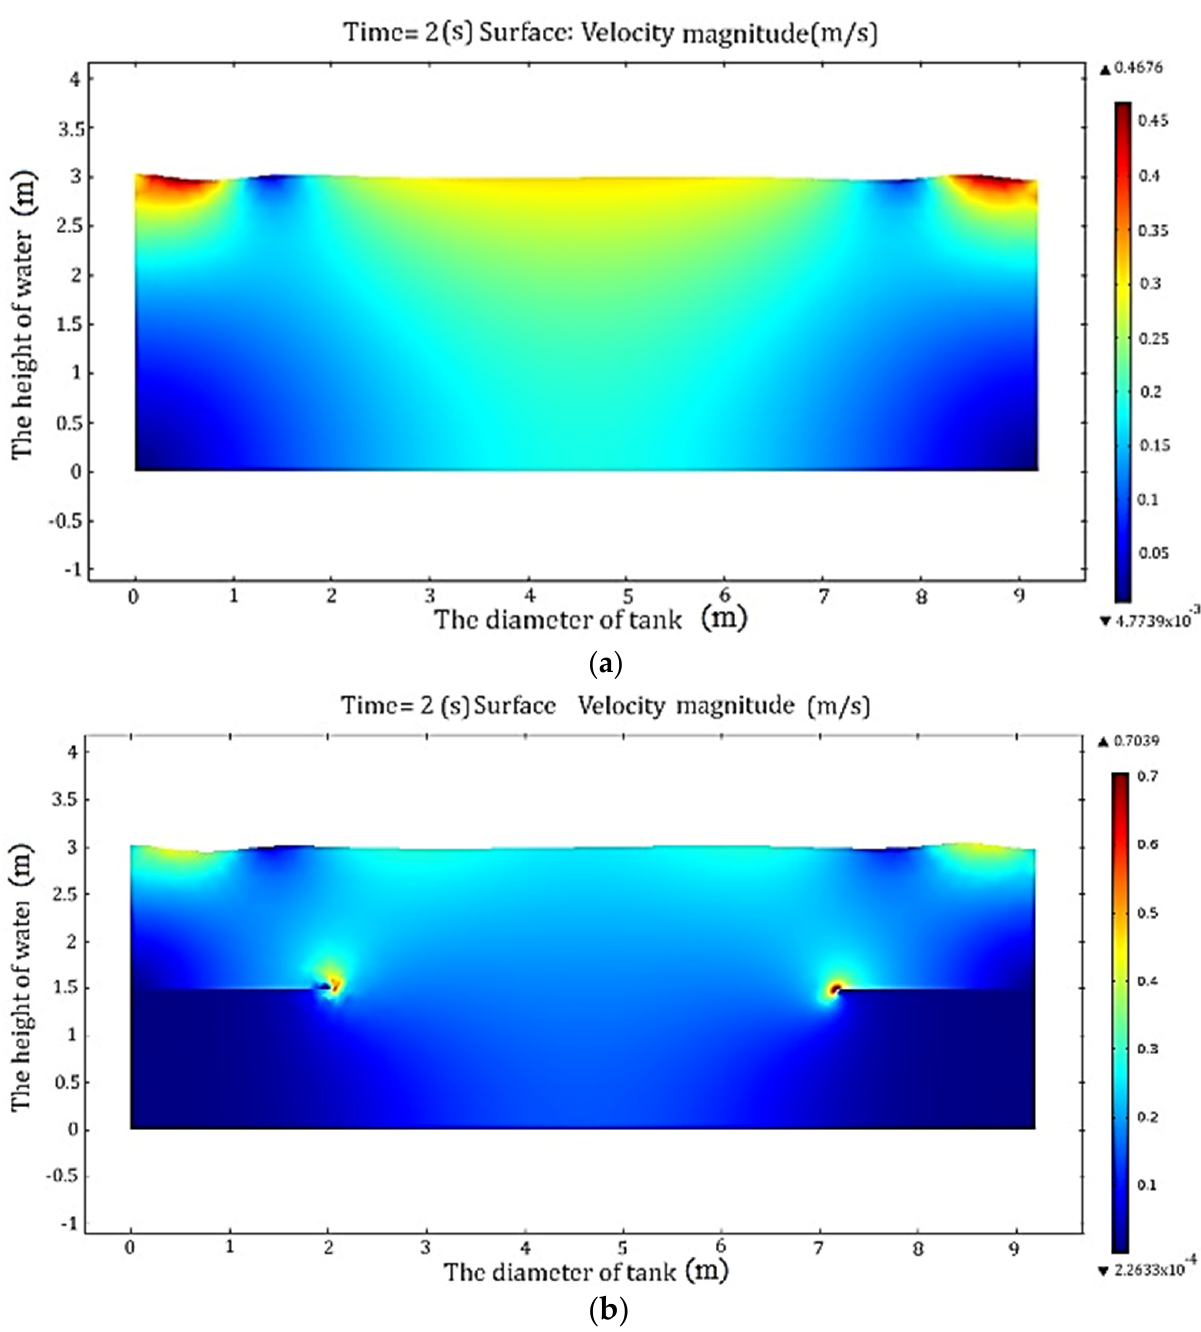
Figure 9. Two-dimensional diagram sloshing of the fluid surface with/without baffle. ( a ) Two-dimensional diagram of the no baffle sloshing of the fluid surface at T = 2 (s); ( b ) two-dimensional diagram of the baffle sloshing of the fluid surface at T = 2 (s).